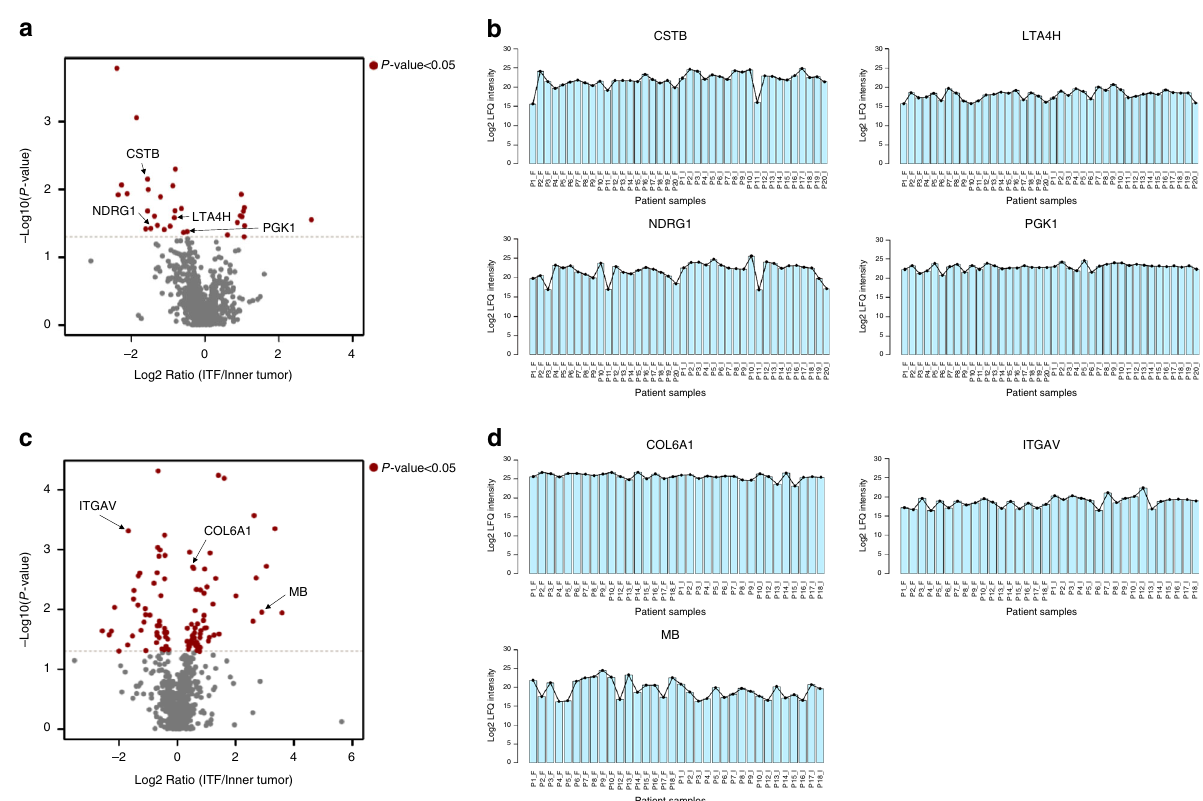
Fig. 3 Abundance pro fi le of proteins selected for veri fi cation steps. a Differentially regulated proteins between the ITF and inner tumor for neoplastic islands, as determined by plotting Student ’ s t test ( P value < 0.05, two-sided) P values versus the log2 ratio of the LFQ intensity (ITF/Inner tumor), are represented on volcano plots. Signi fi cant proteins are indicated by red dots. b Line plots depicting the abundance pro fi les (log2 of the LFQ intensity) of the proteins selected for the veri fi cation step. Shown are the abundances across all MS runs from discovery proteomics analysis of neoplastic island samples. Samples from the ITF are denoted by “ F ” , and samples from inner tumor are denoted by “ I ” . c Differentially regulated proteins between the ITF and inner tumor for tumor stroma (see panel a for plot details). d Protein abundance pro fi les for tumor stroma samples (see panel b for plot